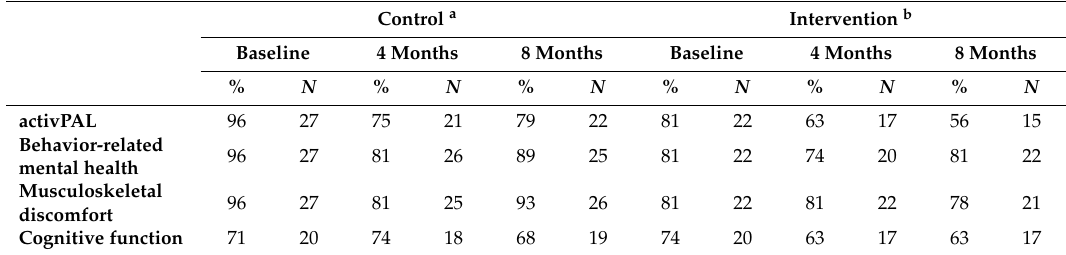
Table 2. Data compliance at each measurement time-point, based on the proportion of participants who wore activPAL monitors at